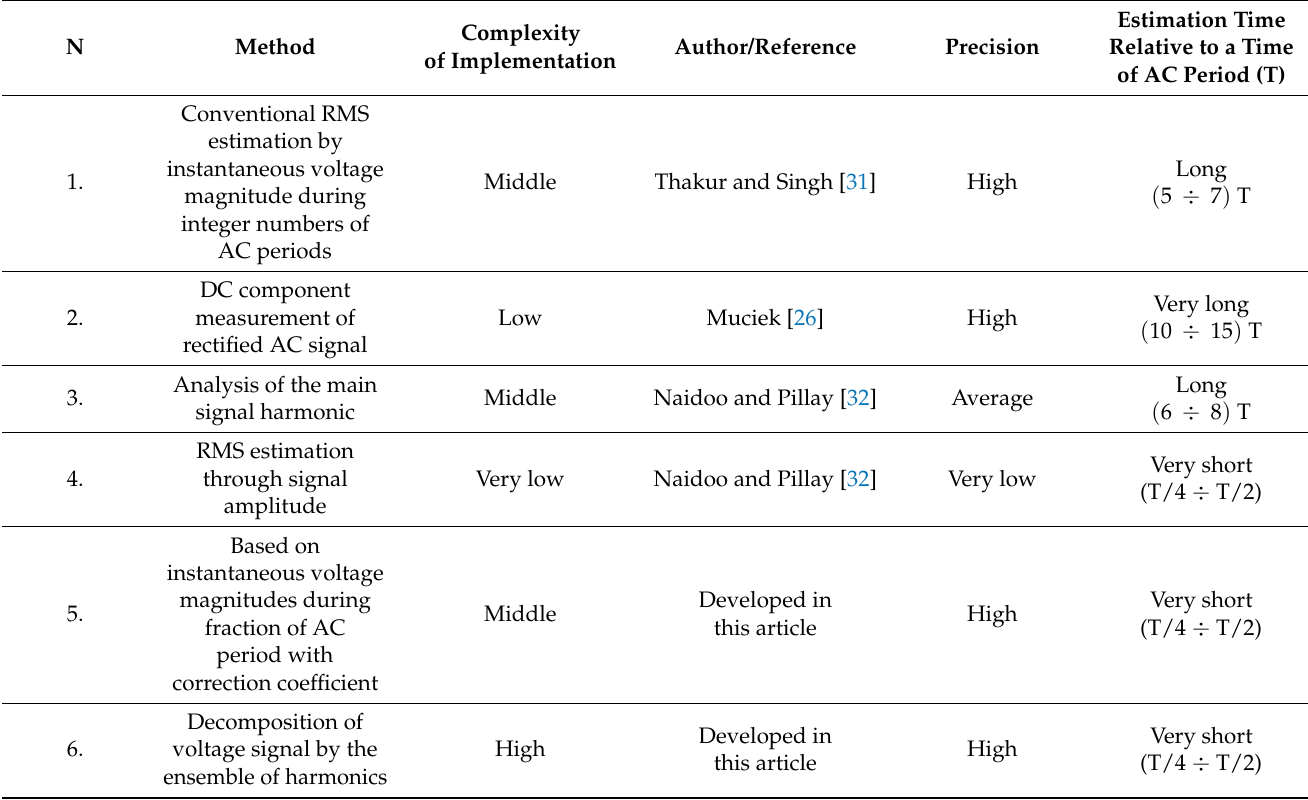
Table 1. Comparing between different methods of a fast RMS